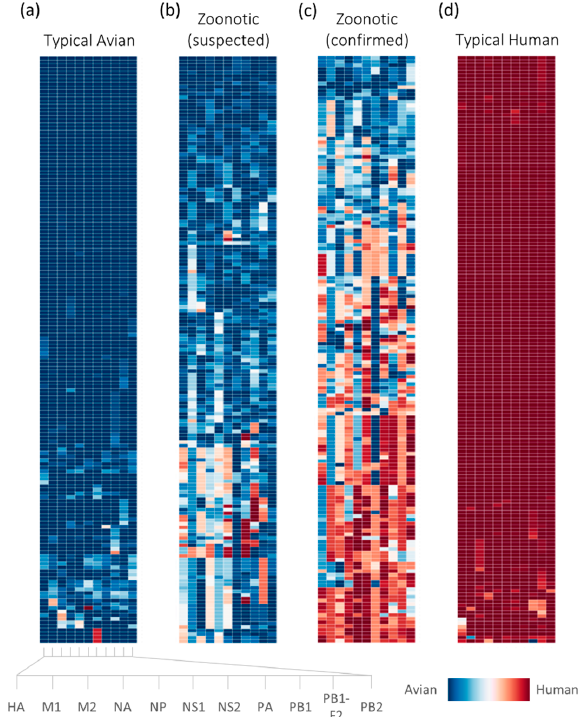
Figure 1. The dataset used in the study represented by host tropism protein signatures of influenza virus strains: 159 typical avian ( a ); 160 human-isolated confirmed zoonotic ( c ), and 164 typical human ( d ) strains were used in the construction of the zoonotic strain prediction model. Additionally, the signatures of a random 165 of 1047 avian-isolated suspected zoonotic strains ( b ) subsequently analyzed using the prediction model are also shown. Each individual virus strain in the bar is represented by the host tropism protein signature laid across the row, with the independent predictions of 11 proteins depicted in each column (HA, M1, M2, NA, NP, NS1, NS2, PA, PB1, PB1-F2, and PB2). Avian protein predictions are illustrated in blue, while human proteins are in red. The confidence of the avian or human host tropism prediction is expressed by the intensity of the color, based on the prediction probability estimates found in Supplementary S1 and S2 datasets. HA: hemagglutinin; M1: matrix protein 1; M2: matrix protein 2; NA: neuraminidase; NP: nucleoprotein; NS1: non-structural protein 1; NS2: non-structural protein 2; PA: polymerase acidic protein; PB1: polymerase basic protein 1; PB1-F2: accessory protein F2 translated from PB1 segment; PB2: polymerase basic protein